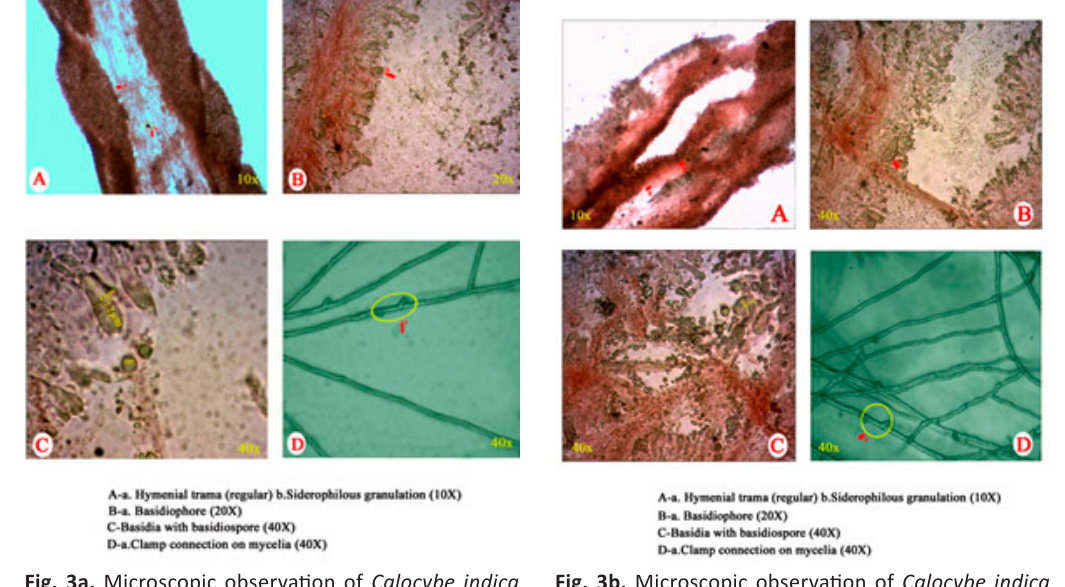
Fig. 3a. Microscopic observation of Calocybe indica Fig. 3b. Microscopic observation of Calocybe indica